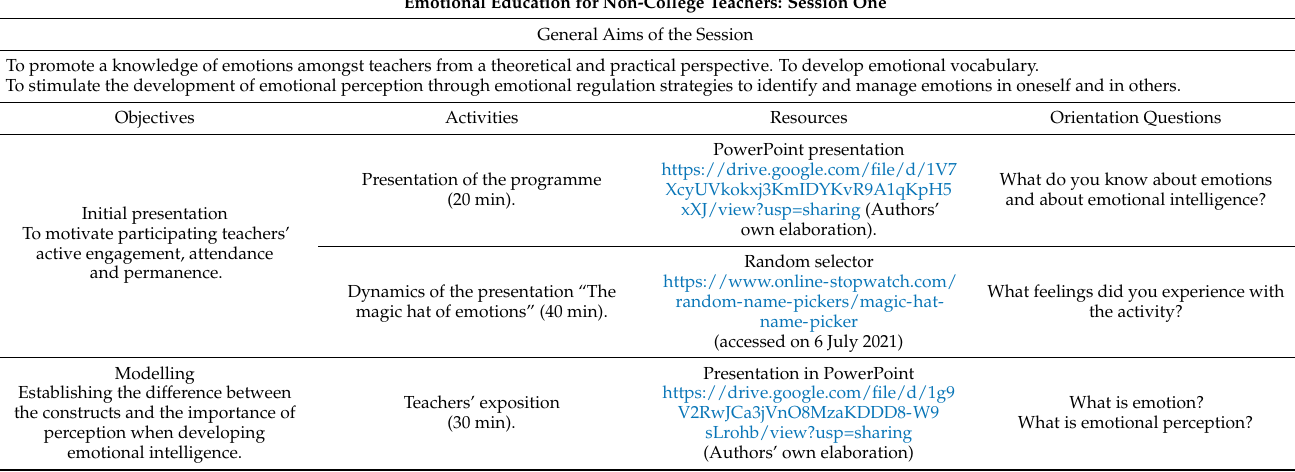
Table 1. Session 1. Emotions: How much do I know and identify my emotions?